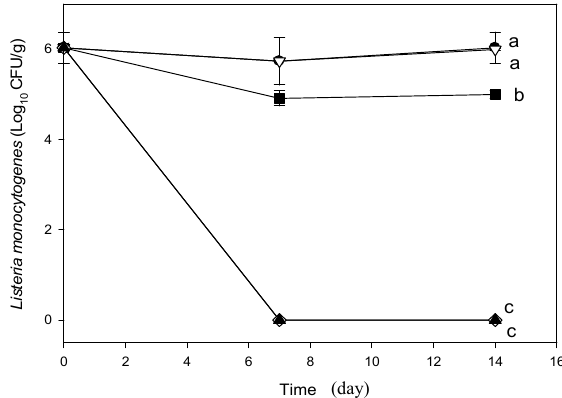
Figure 3. Time course of plate count with Oxford agar of L. monocytogenes in cheese at 4 °C and 22% RH. Symbols: Control (uncoated) ( ); LDPE ( (cid:53) ); ChLA ( (cid:4) ); ChLA-TSA ( ♦ ) and ChLA-TSA-SPI ( (cid:78) ) Data are the average of three determinations. Plots with the same letter in the graph are not significantly different at p < 0.05 as determined by multiple comparisons of means of microbial counts between materials by Tukey-Kramer test.